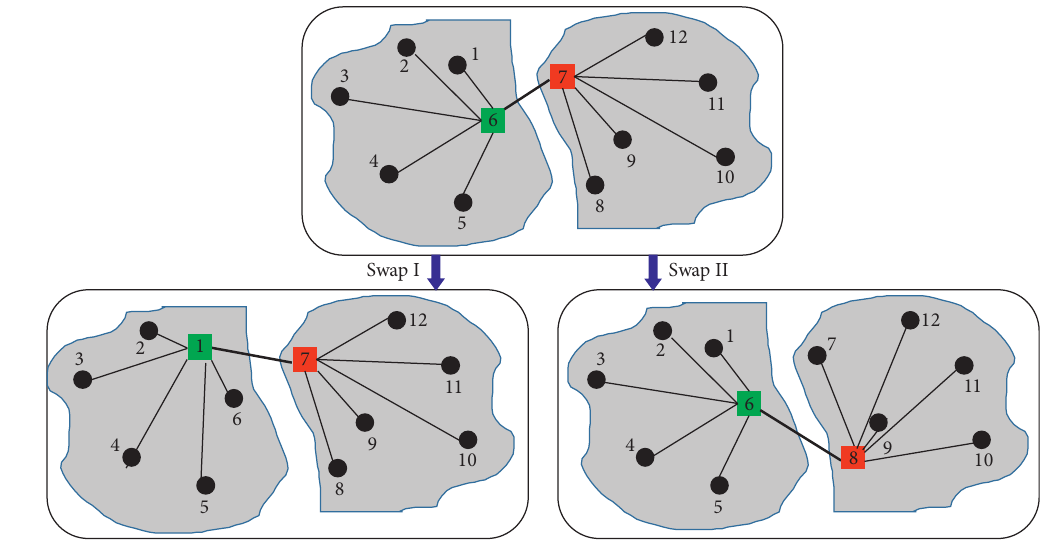
Figure 3: Neighborhood